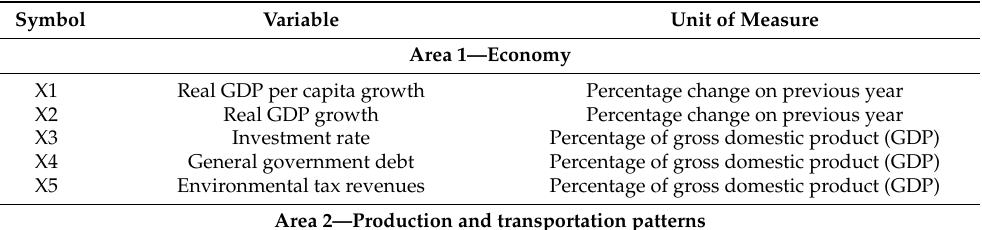
Table 1. Partial indicators (source: own study based on Eurostat data).